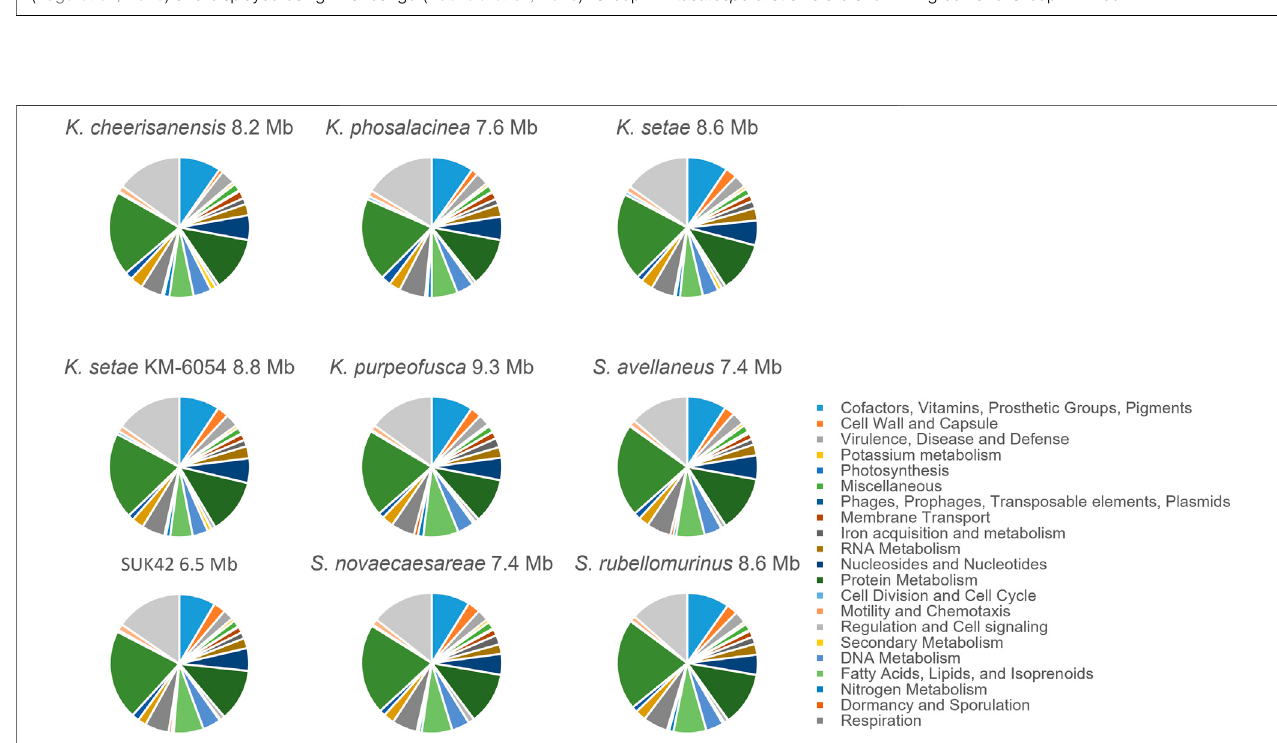
FIGURE 5 | Sub-system comparison of Kitasatospora sp. SUK42 and other putative Kitasatospora reference sequences. Pie charts showing SEED sub-systems determined for Kitasatospora sp. SUK42 and eight other Kitasatospora type strains using RASTtk (Brettin et al., 2015).